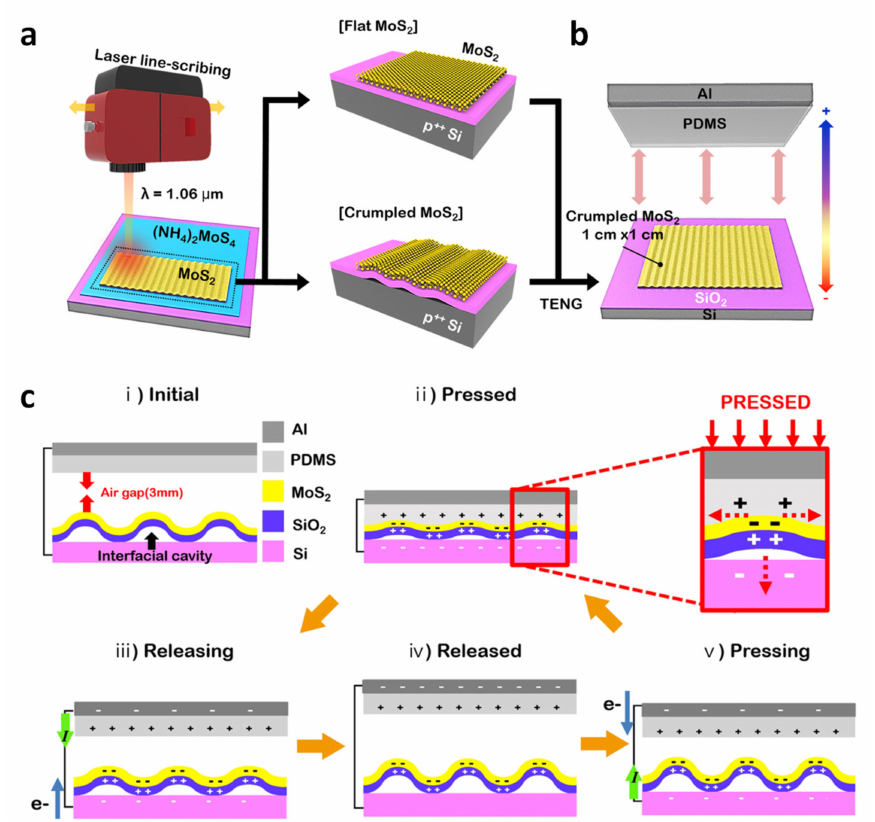
Figure 10. ( a ) Illustration of laser-induced synthesis of 2D MoS 2 on the SiO 2 /Si wafer. ( b ) Illustration of a PDMS-MoS 2 –based TENG device structure. ( c ) Five steps of the mechanism in the fabricated TENG device. Reproduced with permission from [74], Copyright 2020,